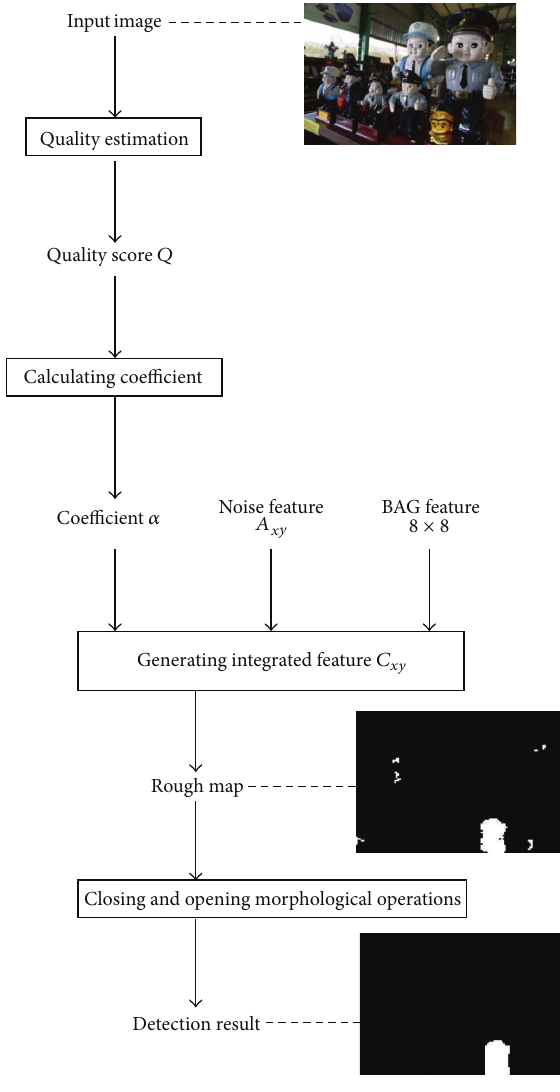
Figure 6: Flowchart of proposed method: combination of two